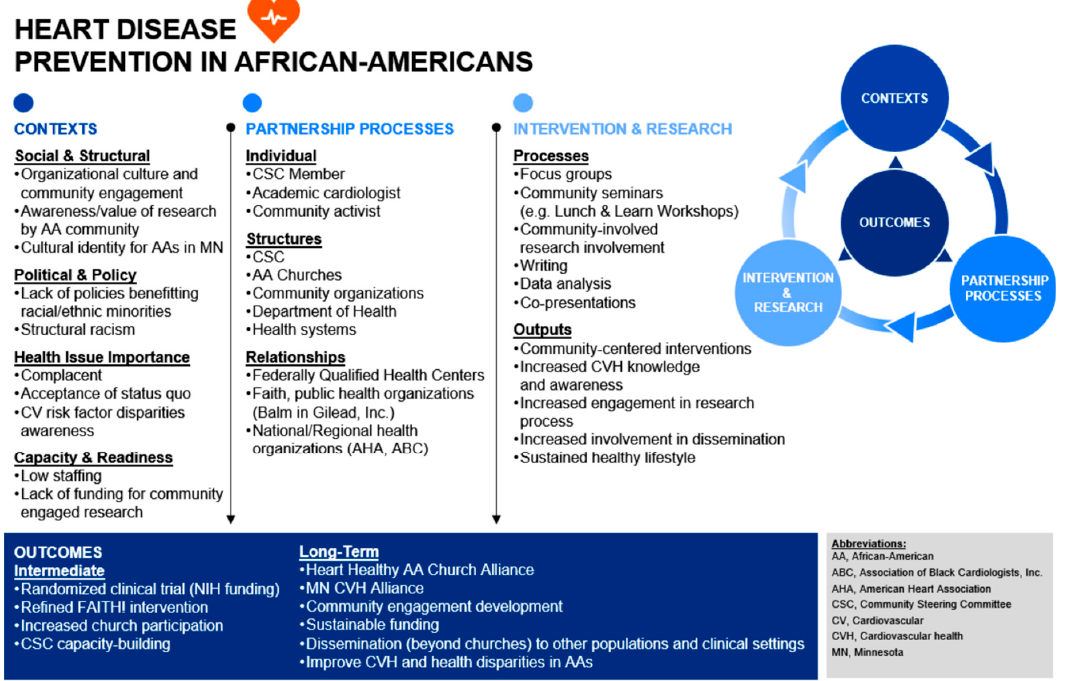
Figure 3. Community-based participatory research (CBPR) conceptual model for the FAITH! Community Steering Committee.